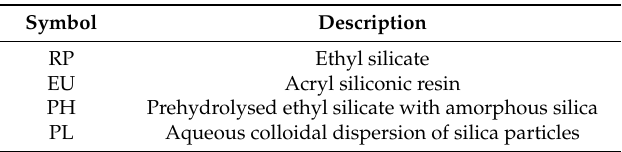
Table 2. Description of consolidants.